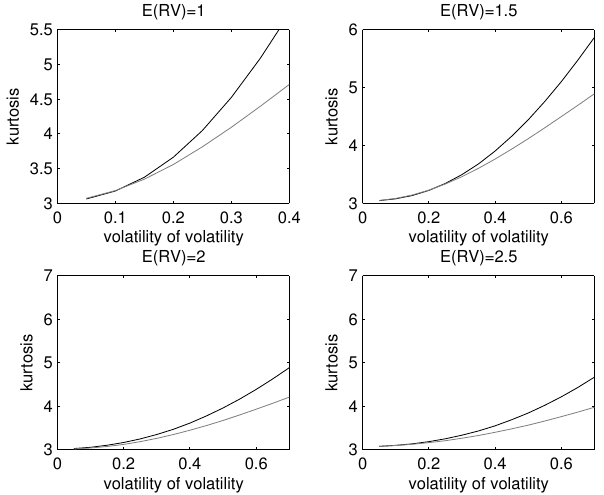
Figure 1. The kurtosis of the simulated distribution under the assumption that shocks to realized volatilityhave the normal inverse Gaussian (NIG) (upper line) and normal distributions.